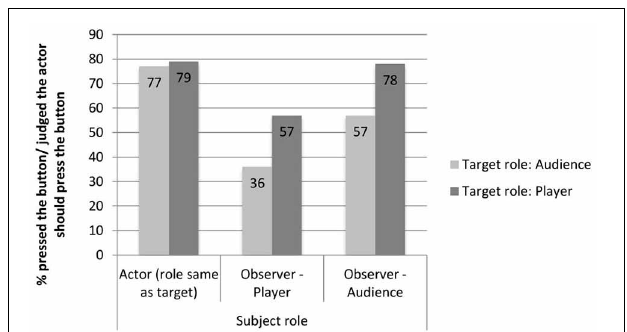
FIGURE 5 | Percentage of actors who pressed the button, and percentage of observers who judged that their target should press the button, broken down by the role of the subject and the role of the target.